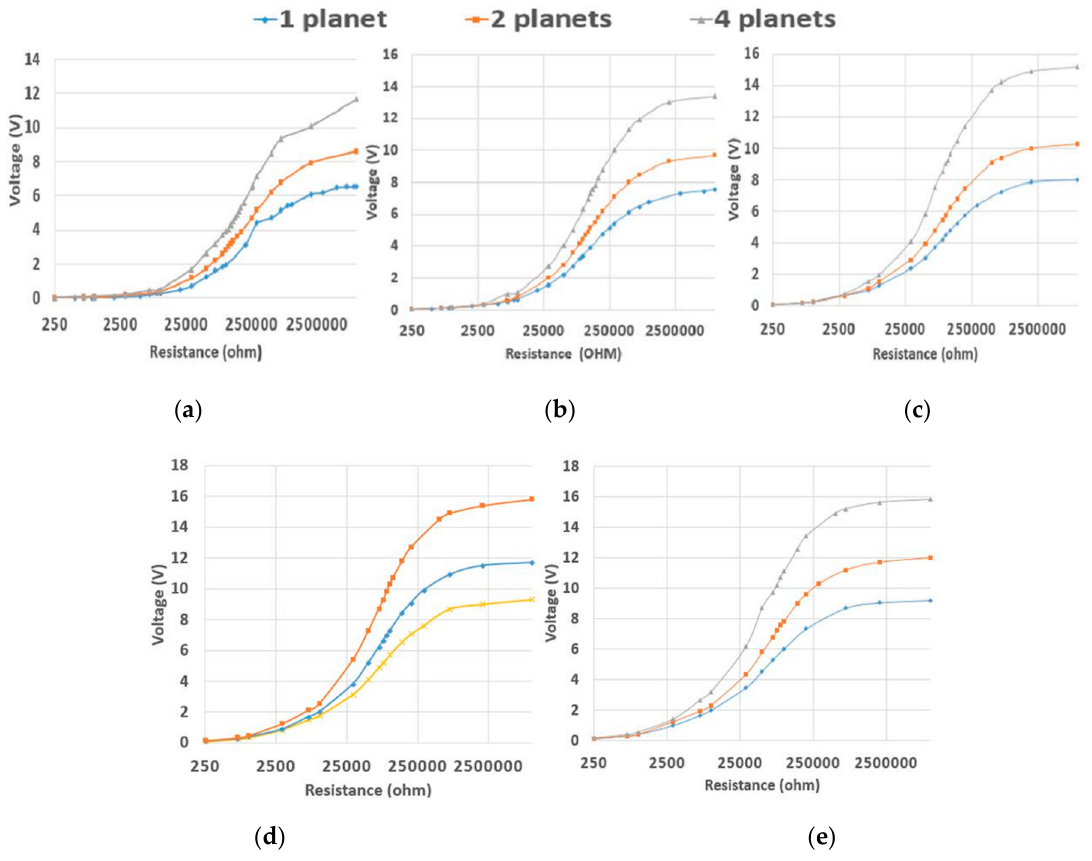
Figure 14. Effect of planet cover number increase on voltage increase with different rotational speeds: Figure 14. E ff ect of planet cover number increase on voltage increase with di ff erent rotational speeds: ( a ) 300 rpm, ( b ) 600 rpm, ( c ) 900 rpm, ( d ) 1200 rpm and ( e ) 1500 rpm. ( a ) 300 rpm, ( b ) 600 rpm, ( c ) 900 rpm, ( d ) 1200 rpm and ( e ) 1500